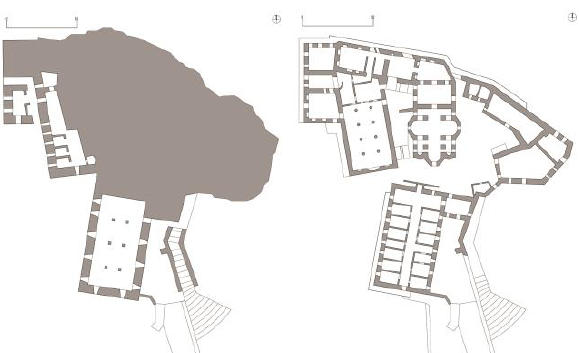
Figure 20 . The Monastery of St Paul. General